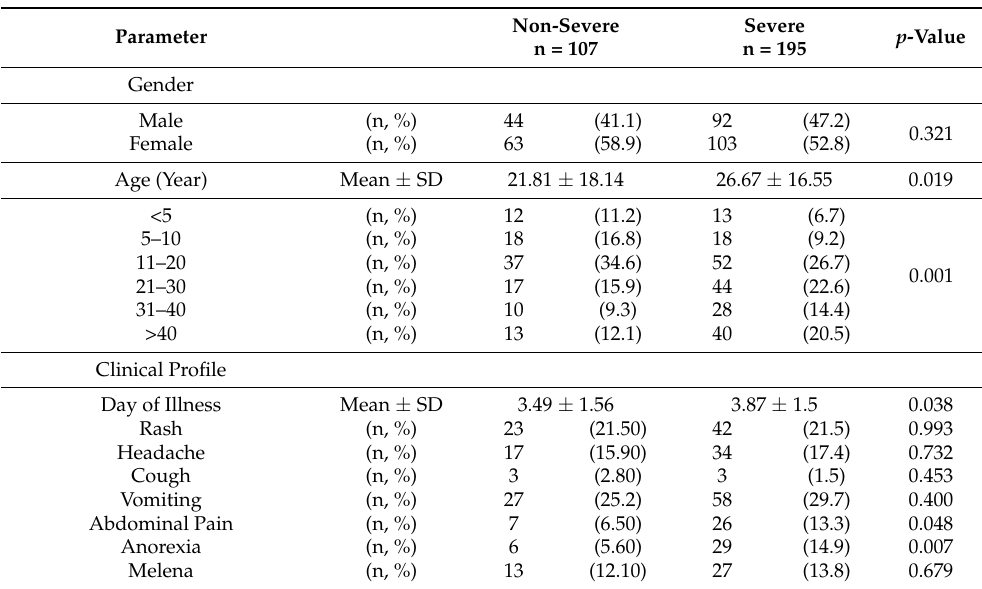
Table 2. Clinical parameters of subjects by severity of infection (non-severe infection vs. severe infection as categorized by WHO 2009